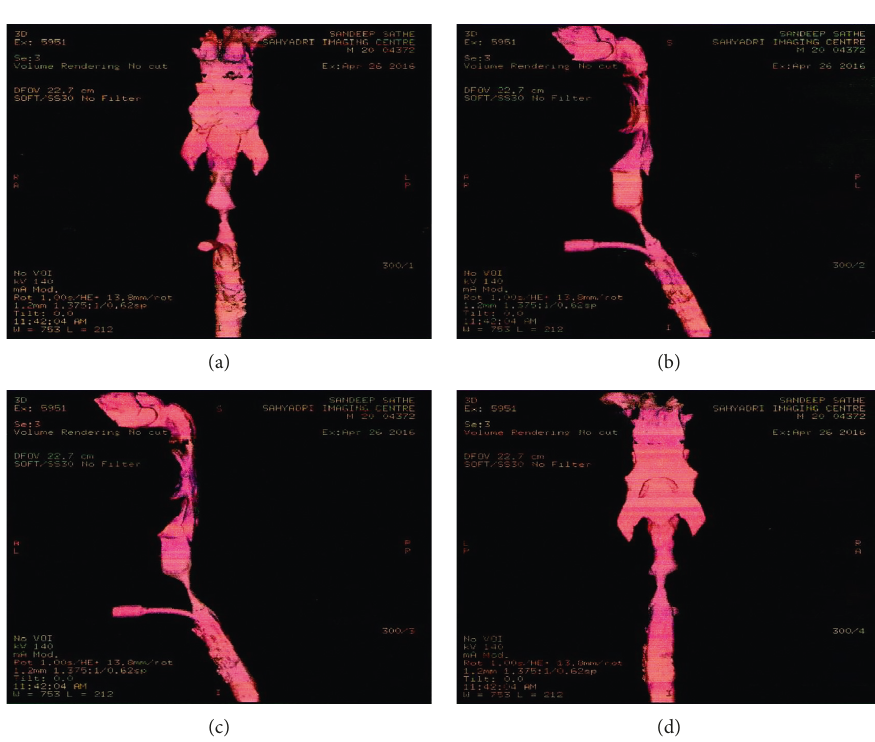
Figure 2: 3D CT neck showing stenotic